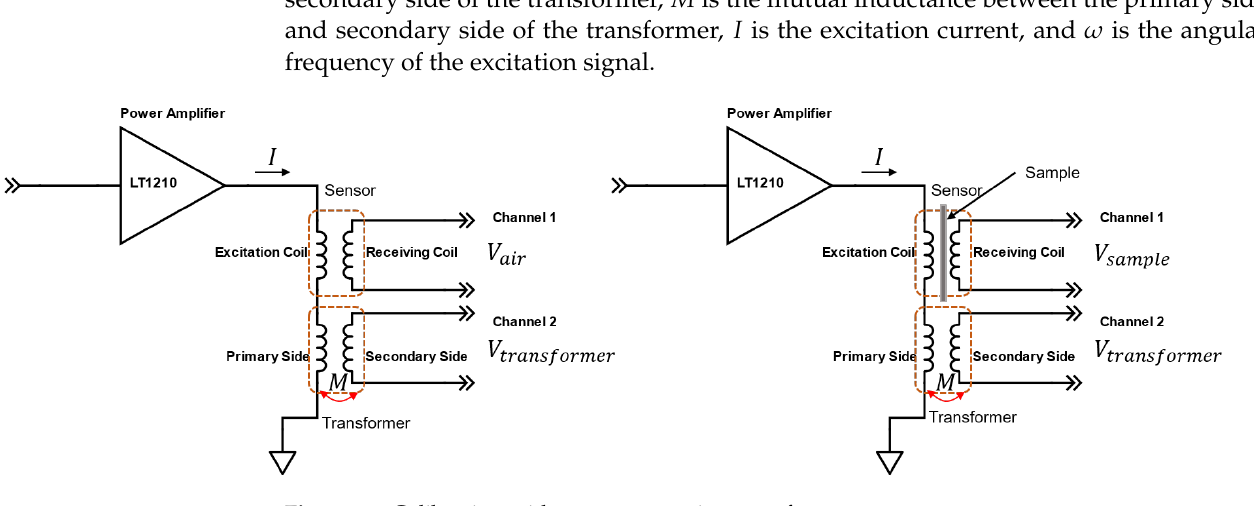
Figure 14. Categories of the eddy-current